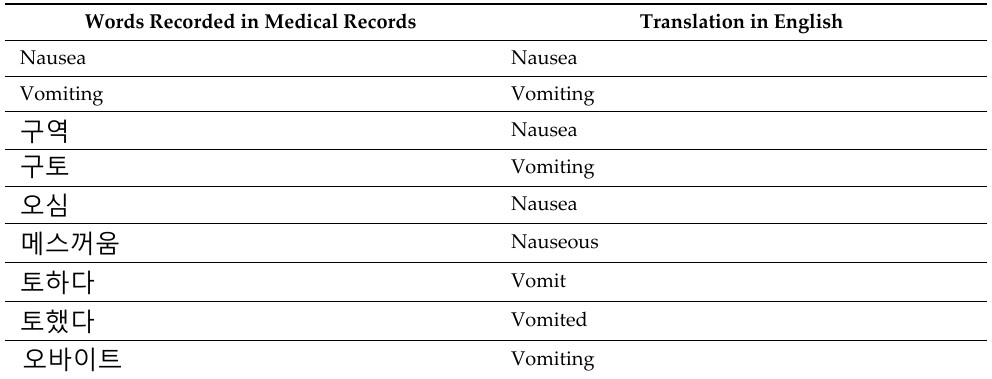
Table A1. Words that represent postoperative nausea and vomiting.